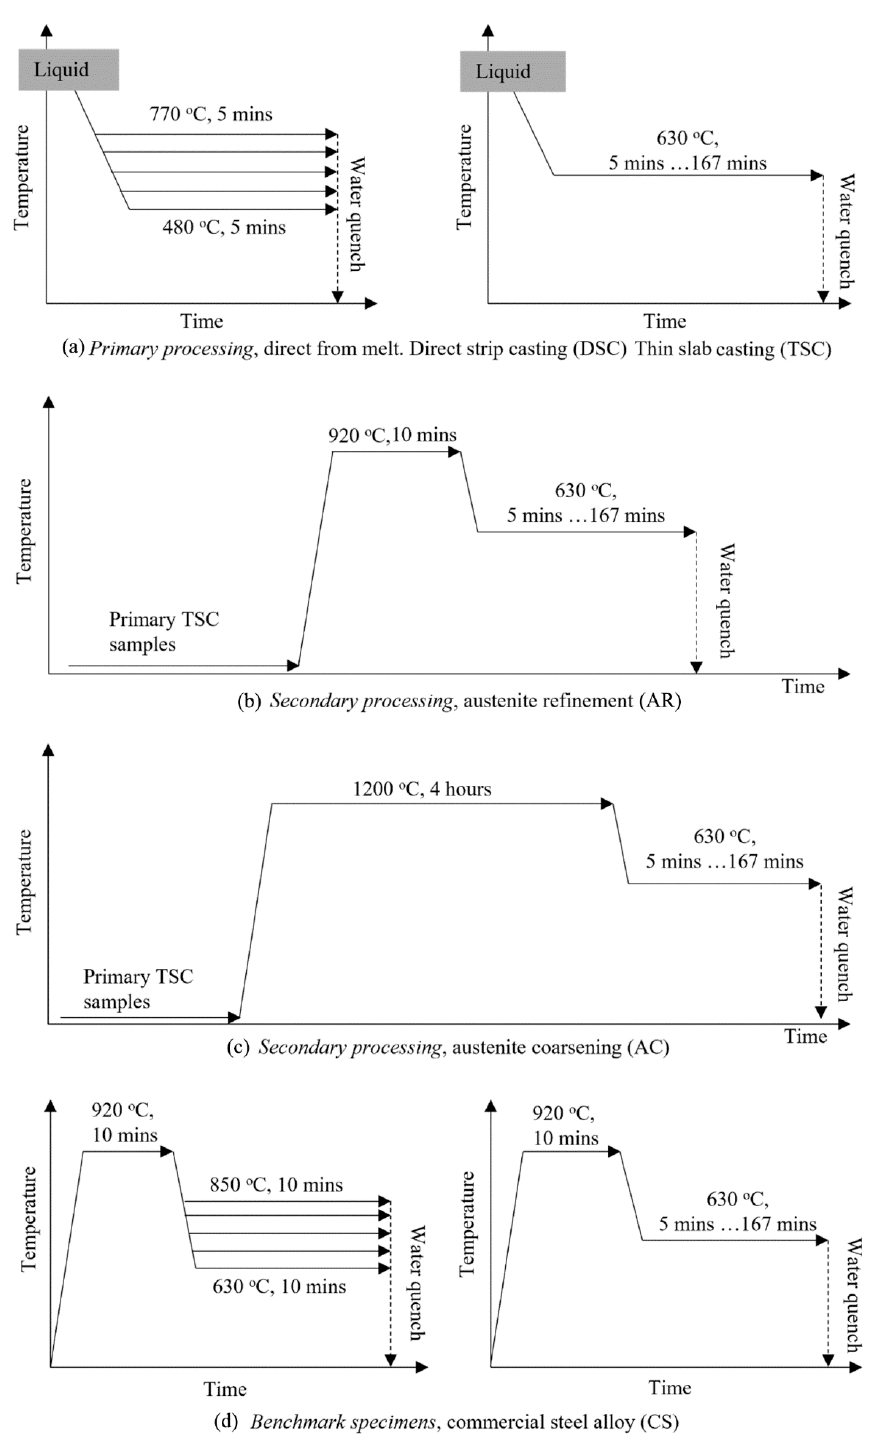
Figure 2. Schematic of heat treatment procedure for ( a ) primary processed steel for samples taken directly from the melt; ( b ) secondary processed specimens that had a refined austenite grain size; ( c ) secondary processed specimens that had a coarsened austenite grain size; and ( d ) commercial steel specimens that were given comparable heat treatments to benchmark transformation kinetics .